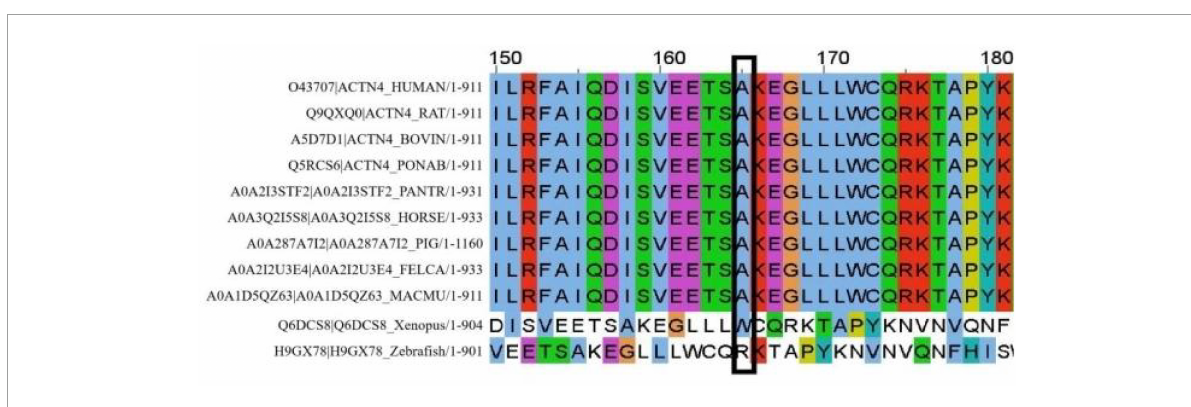
FIGURE3 In total, 30 amino acids surrounding the variant position (marked with a black